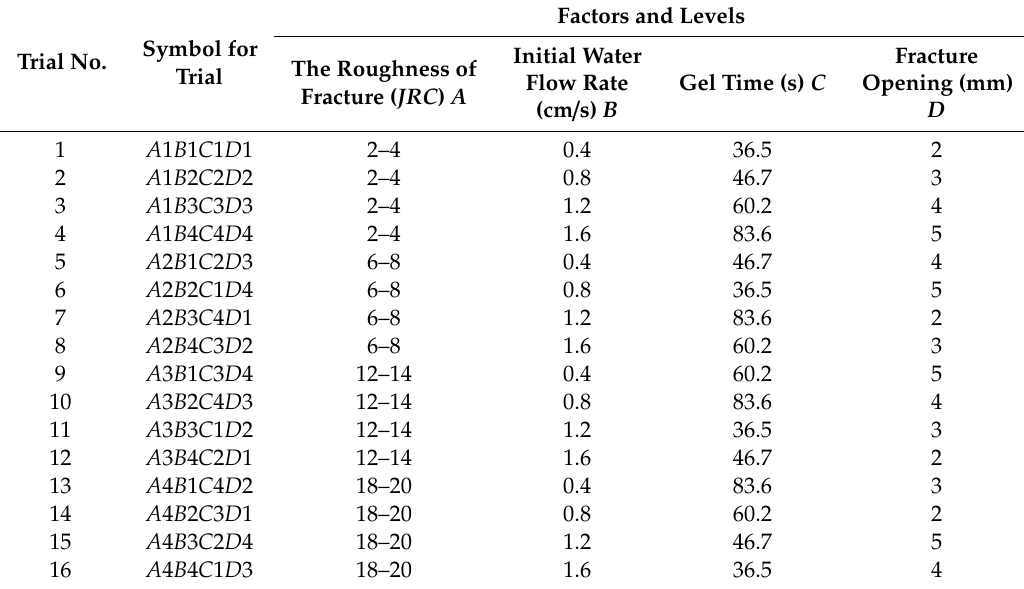
Table 2. Orthogonal array for chemical grouting in a rough fracture with flowing water.